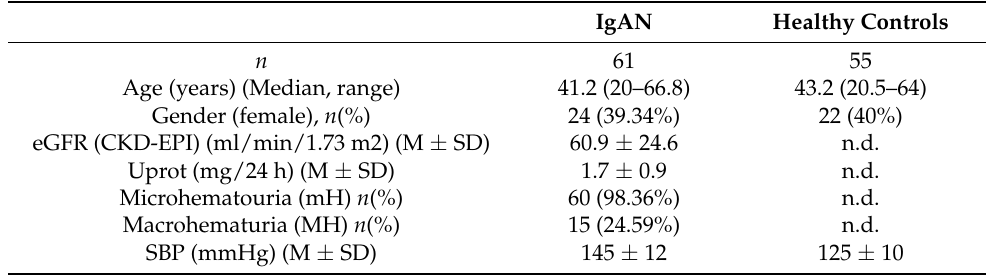
Table 1. Clinical data, laboratory, and histological findings of IgAN patients at time of diagnosis and last